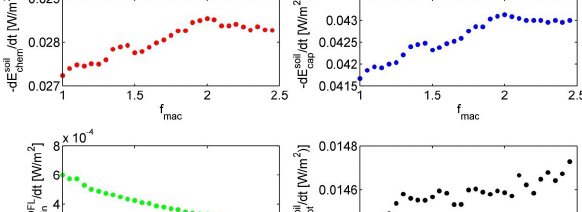
Fig. 9. Time series of potential energy input by rainfall (a) , kinetic Figure 9: Time series of potential energy input by rainfall (panels a), kinetic energy export by energy export by surface runoff (b) temporal changes in potential, surface runoff (b), temporal changes in potential, absolute values of capillary binding energy absolute values of capillary binding energy and total free energy of and total free energy of soil water (panels c) during the largest flood event in June 1994. soil water (c) during the largest flood event in June 1994.